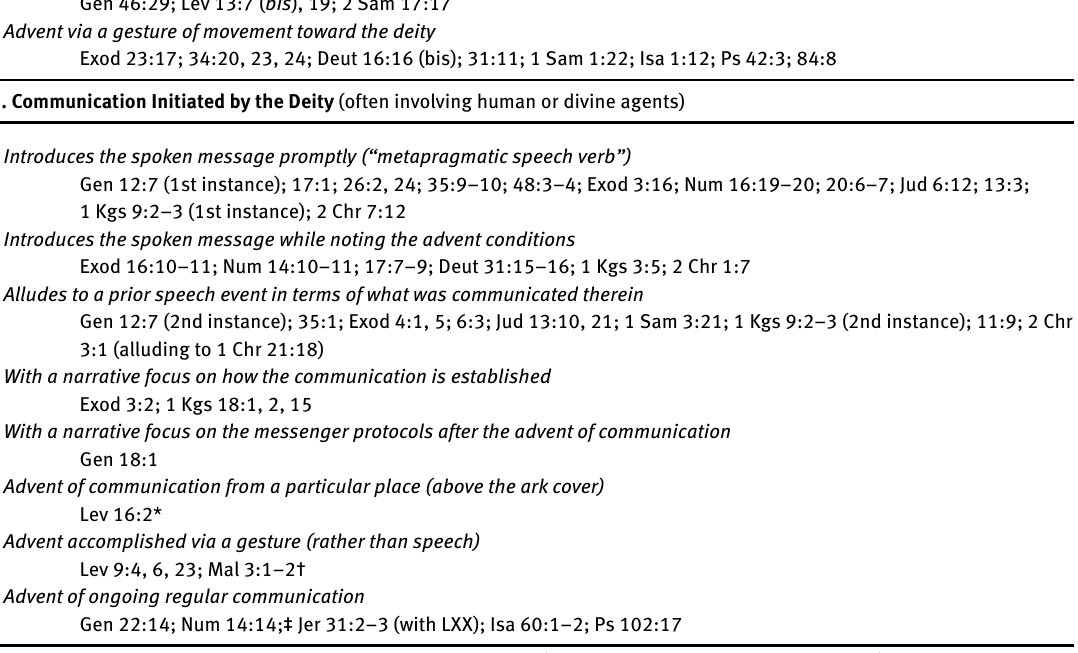
I. Communication Initiated by Human Beings (not as the deity’s agents) Advent via a gesture of movement toward other human